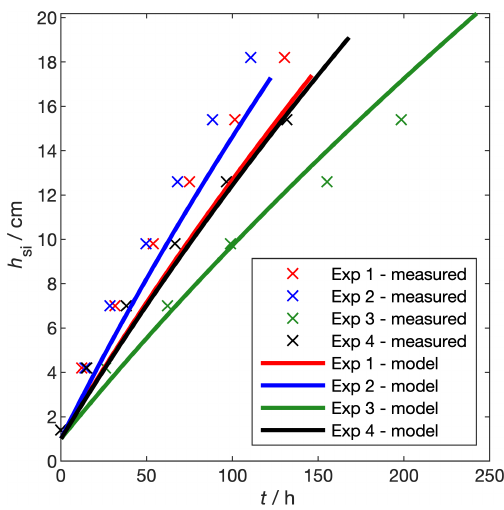
Figure 12. Thickness measured from temperature profiles dur- ing the experiments presented in Sect. 3.1.3 and modelled using Eq.